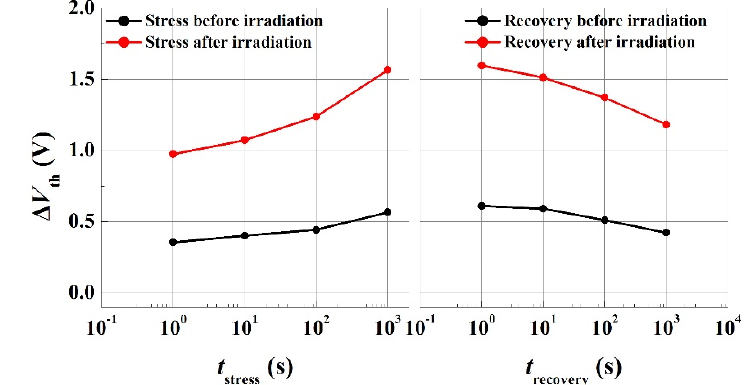
Figure 3. Stress and recovery behavior of normally-off AlGaN/GaN gate-recessed metal–insulator–semiconductor heterostructure field effect transistors (MISHFETs) up to 1000 s with a V GS = 8 V before and after proton irradiation.